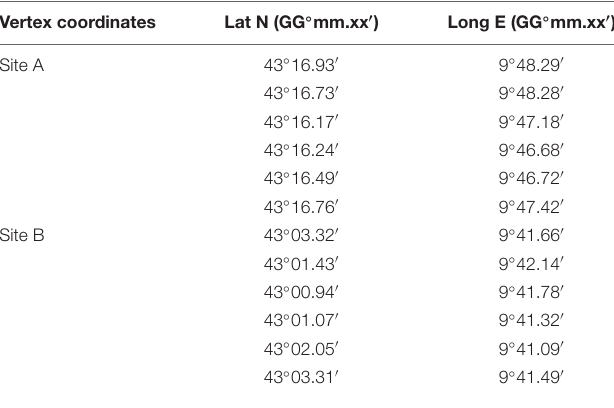
TABLE 3 | Vertex coordinates of the proposed protected polygons for sites A and